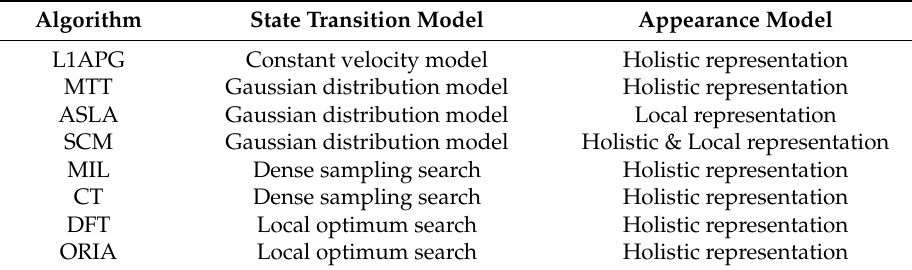
Table 1. Basic information of the eight state-of-the-art tracking algorithms.